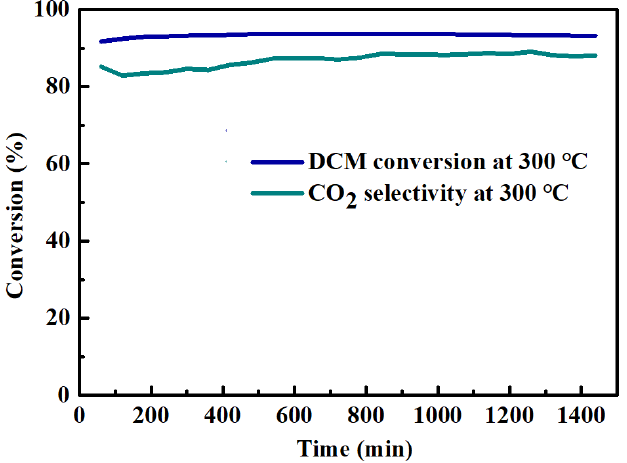
Figure 2. Stability evaluation test results of the c-1-RuST sample.